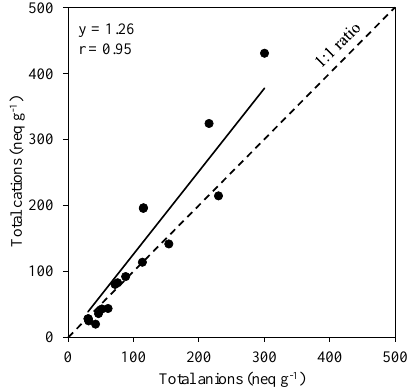
Figure 7. Linear regression plots between total cation equivalents (neq) and total anion equivalents (neq) in melt snow samples at the Murodo-Daira site near Mt.